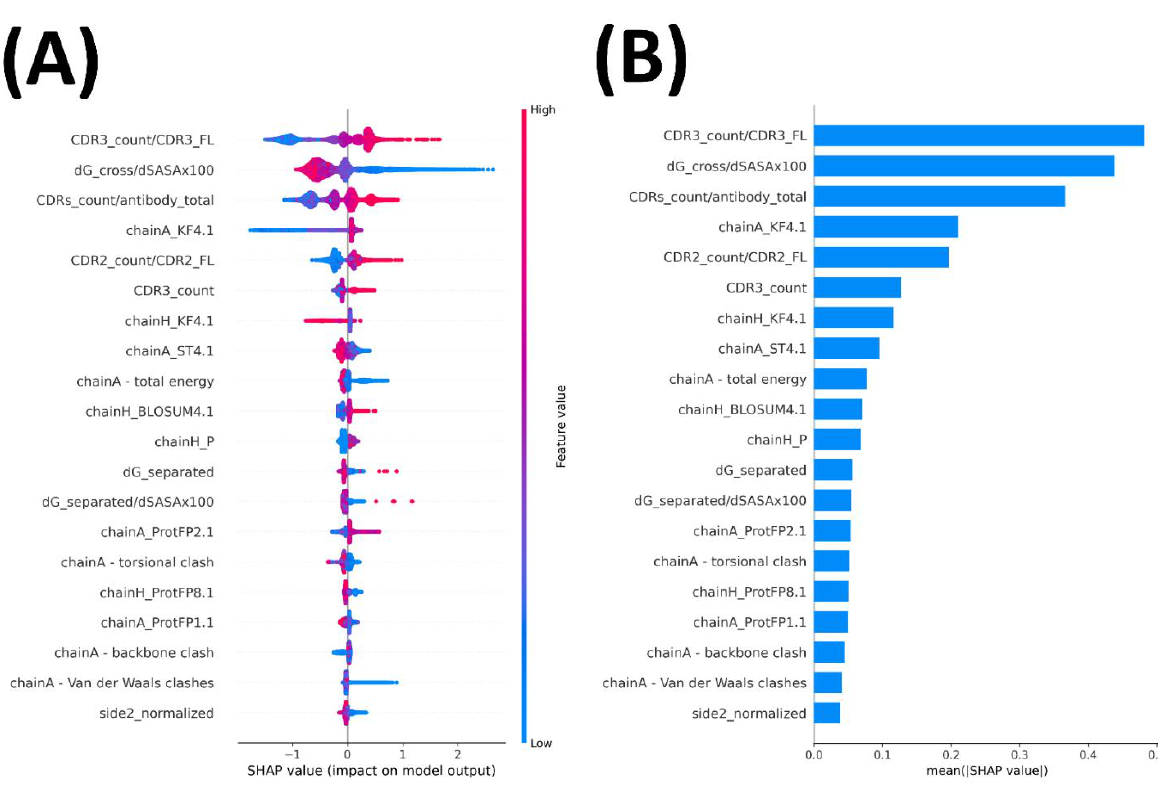
Figure 3. Summary plots of SHAP values of important features contributed to the prediction of NbX in the best single model. ( A ) Scatter plot of SHAP values including directionality of contribution to the predicted probability of nativeness. Each dot represents one prediction in the test set. On the horizontal axis representing the SHAP value, a positive SHAP value represents a positive contribution to the predicted probability and vice versa. The color of dots represents the feature values relative to the maximum and minimum of that feature, which are colored red and blue, respectively. ( B ) Bar plot of mean (|SHAP|) of the important features, which represents the averaged importance of each feature to the test set prediction overall regardless of the directionality of the contribution. ChainA represents Ag and chainH represents Nb.